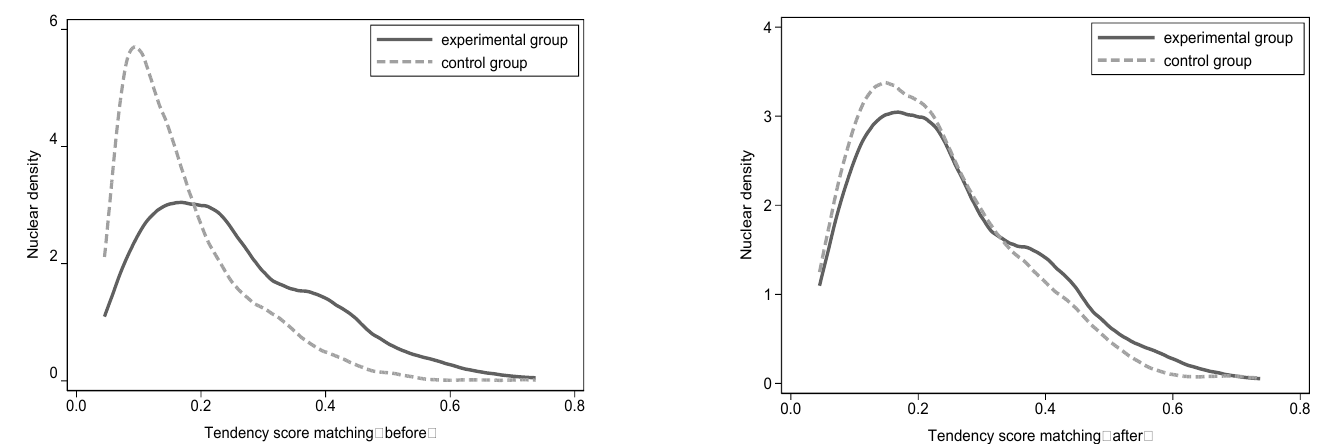
Figure 5. Probability Distribution Density Function of Tendency Score.